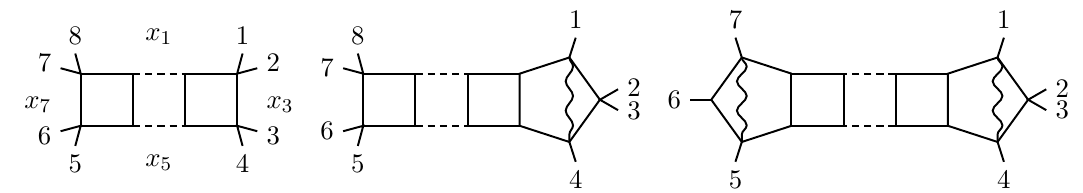
Figure 1 . The (eight-point) box-ladder, (eight-point) penta-box-ladder and (seven-point) double- penta-ladder